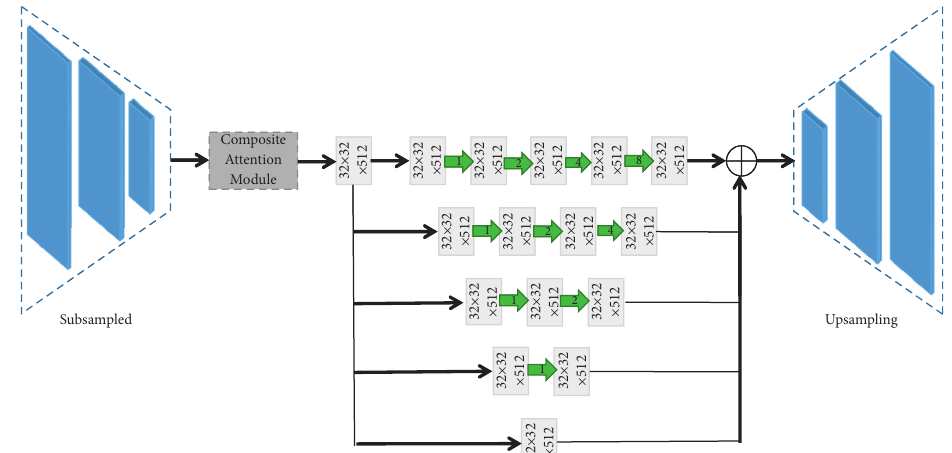
Figure 7: Structure frame diagram with attention composite